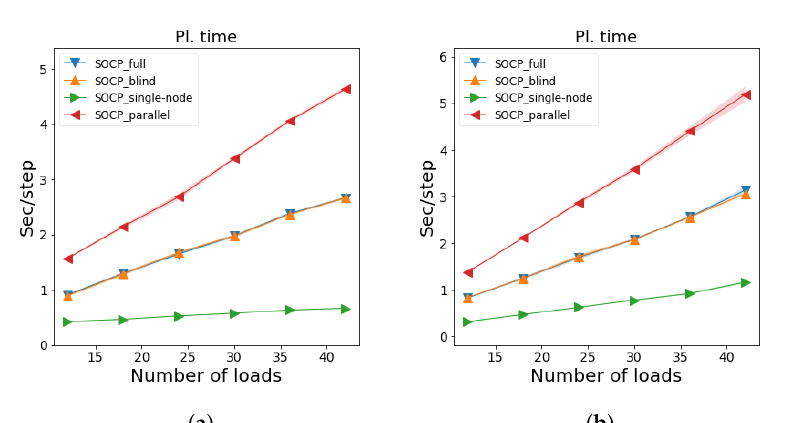
Figure 9. Planning time per timestep for different grid sizes. ( a ) Random radial grid with DGs with 3 cables each of equal length varying from 4 to 14 ( b ) Random radial grid with DGs with cables of length 6. The amount of cables varied from 2 to